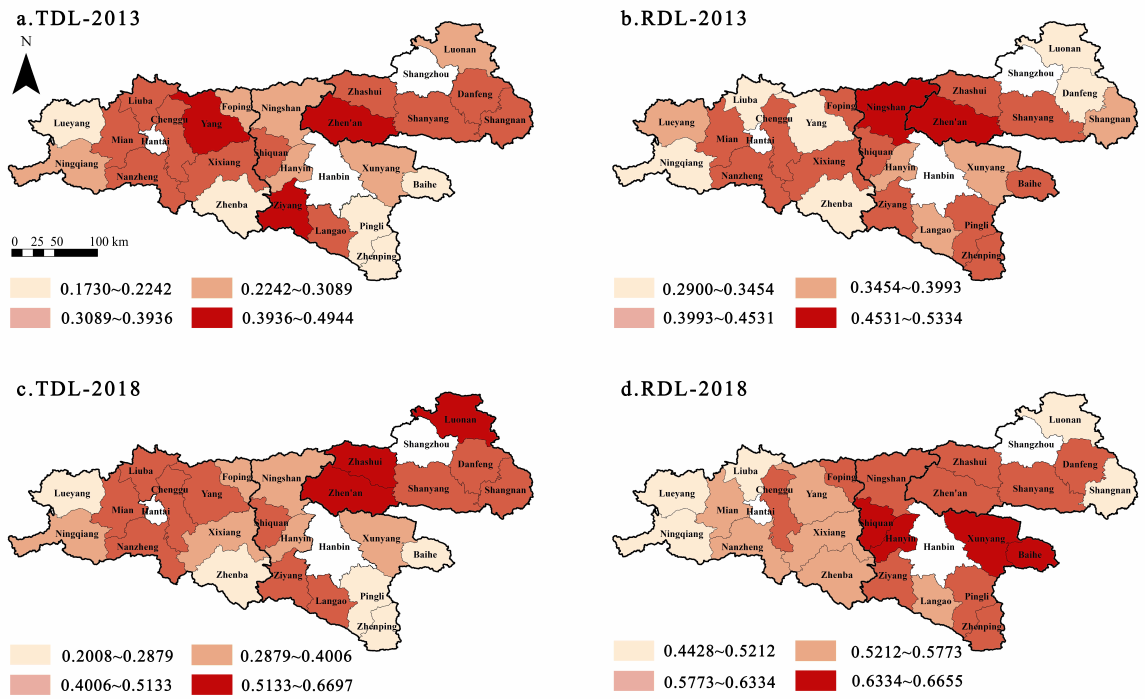
Figure 4. The evaluation results of TDL, RDL, TDE, and RRE.